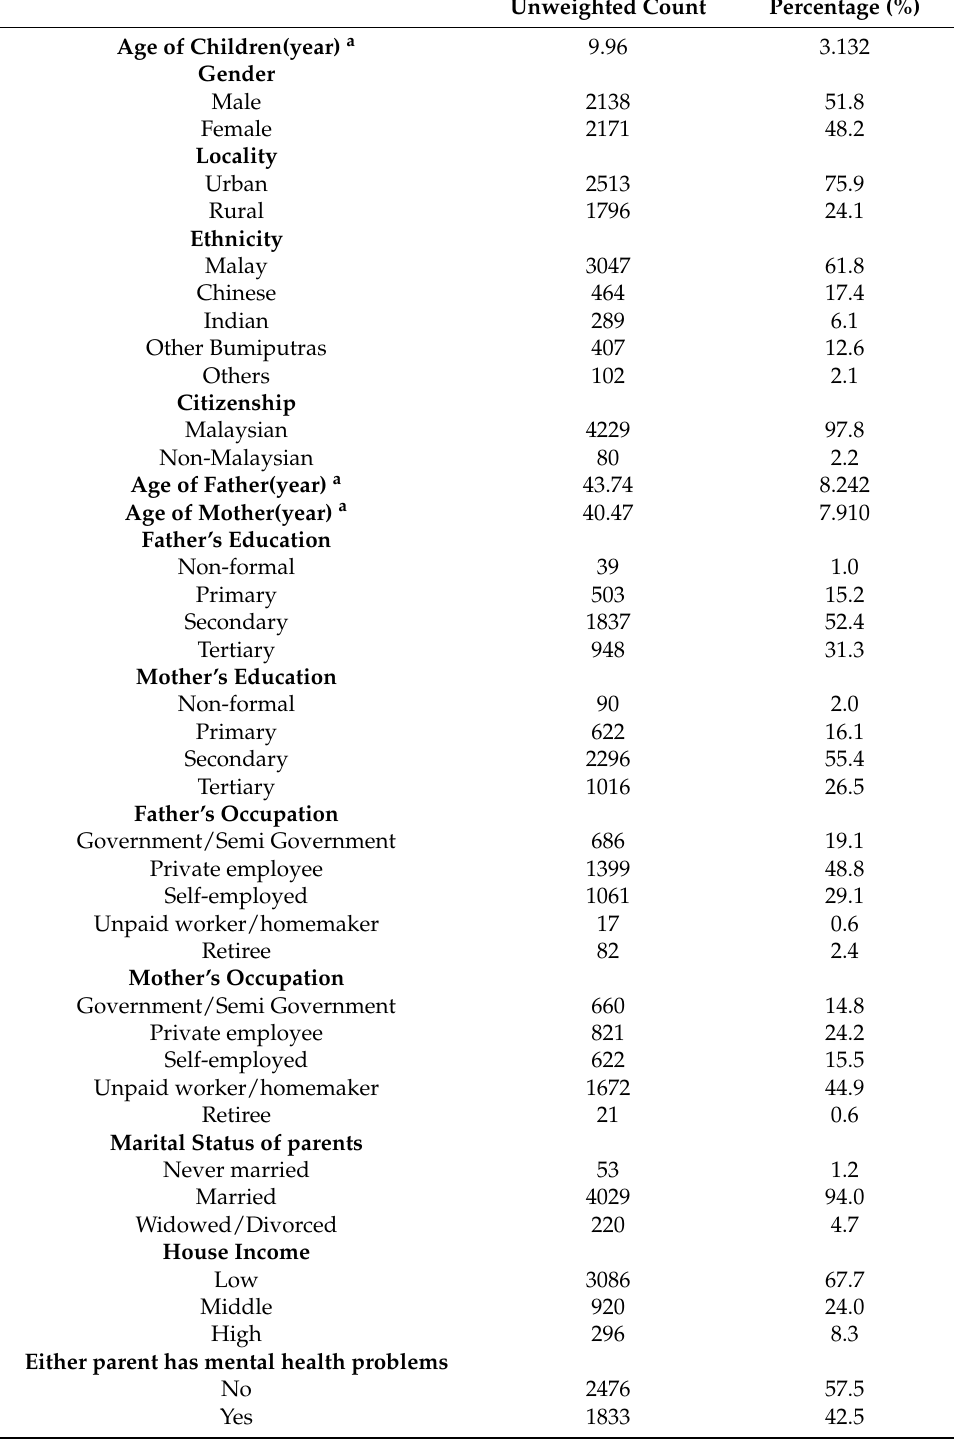
Table 1. Sociodemographic profile of the respondents ( n =